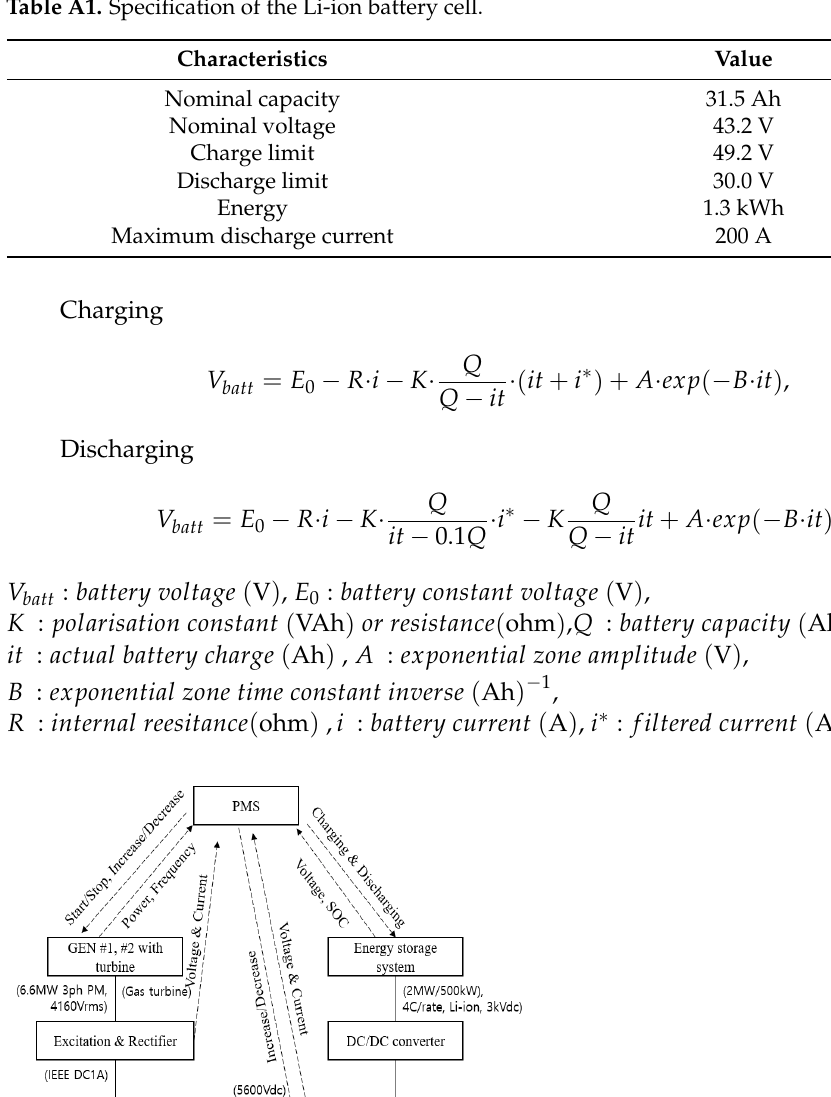
Figure A6. Example of PMS operation in prime mover trip scenario. References 1.